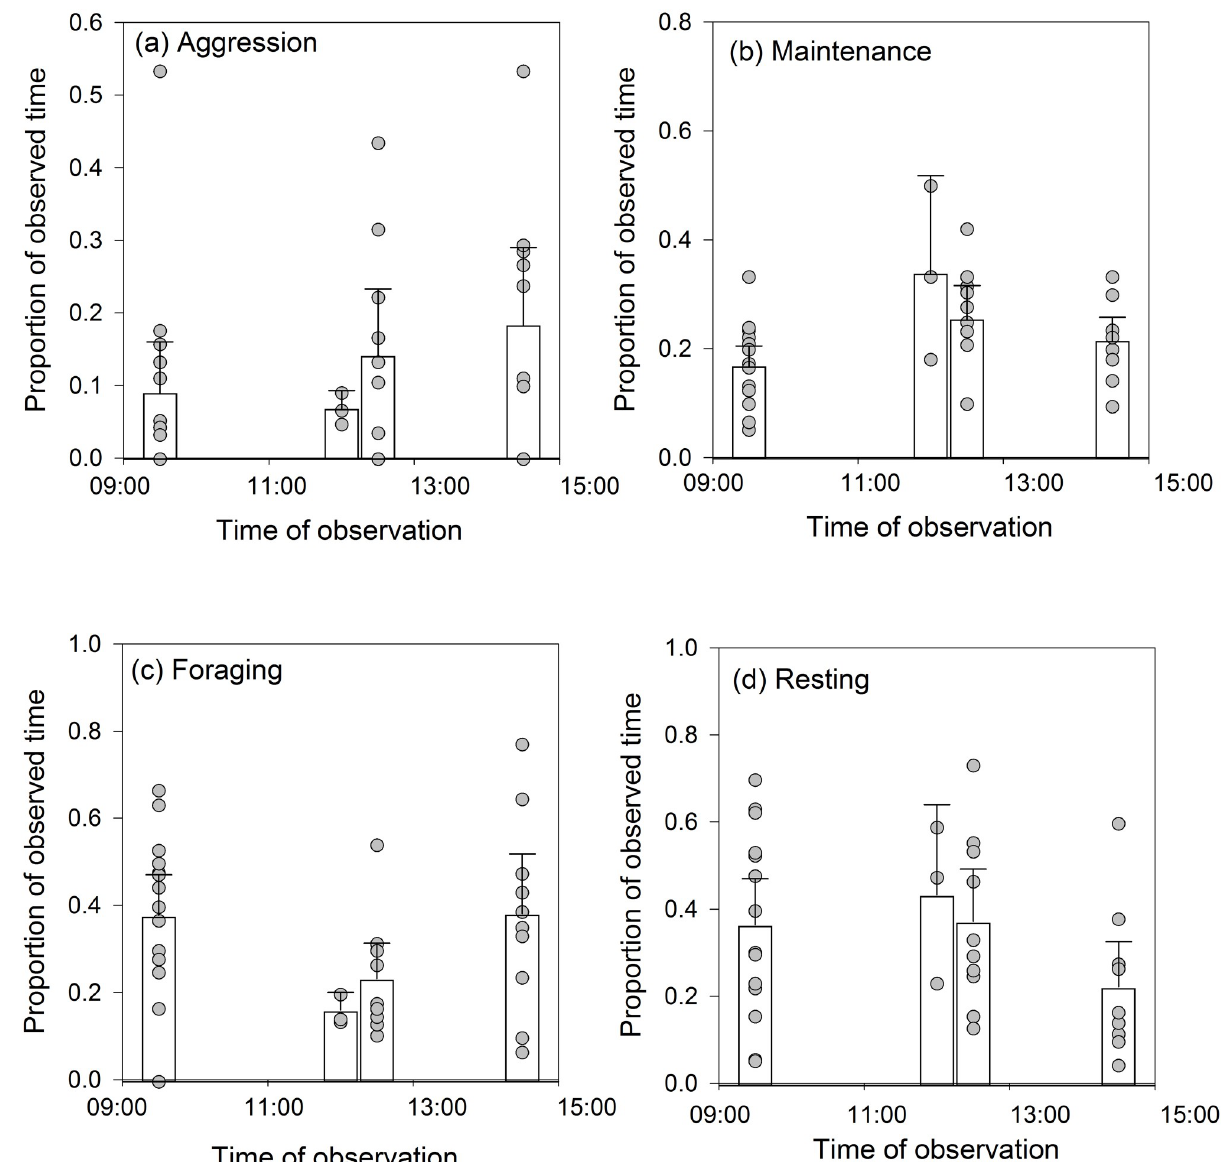
Fig 3. Observed whooper swan behaviour at different times of day. The bars represent the mean ± 95% CI time spent on each behaviour, whilst the filled circles represent the individual data points.